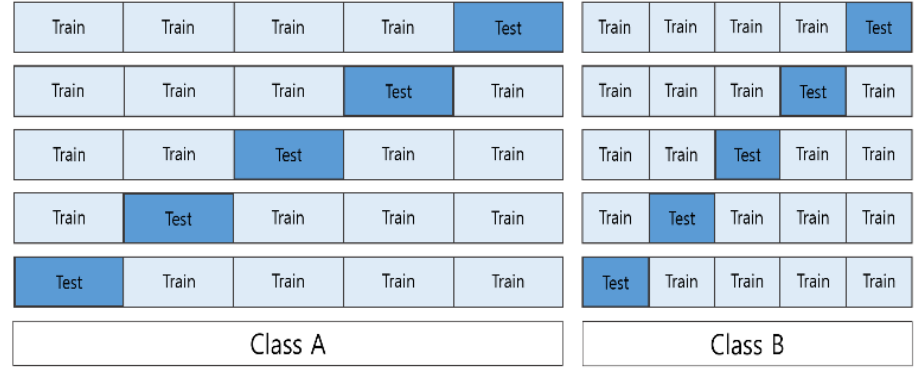
Figure 8. Visual representation of cross validation.